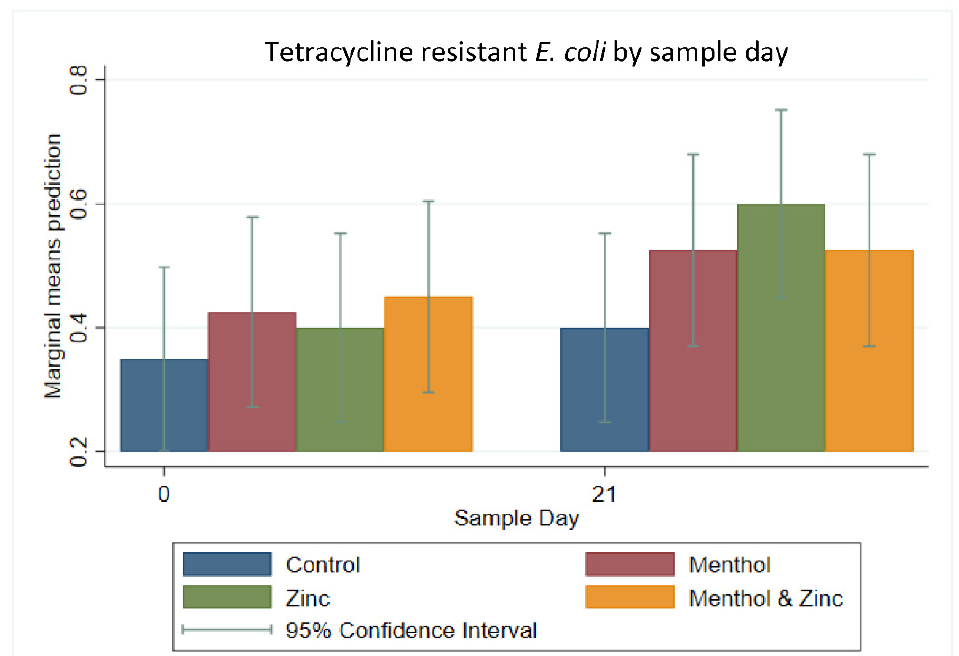
Figure 5. Marginal means with 95% confidence intervals of a 2 × 2 × 2 multi-level mixed logistic regression model, using factors of zinc, menthol and sample day on the binary outcome of tetracycline resistant E. coli.